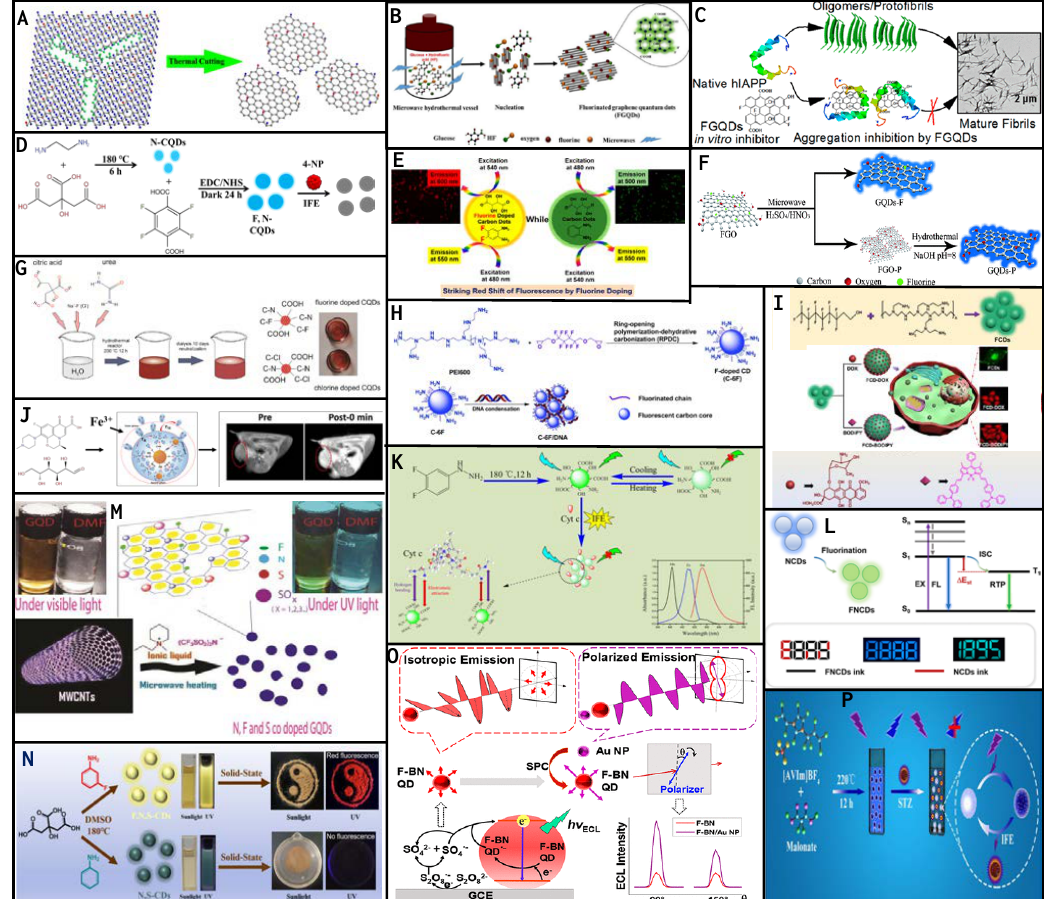
Figure 5. Synthesis and applications of F-doped CDs [59,61]. ( A ) F-GQDs were prepared using pyrolytic fluorinated graphite at 810 K. ( B ) HF was used as the dopant, and F-GQDs were synthesized by the microwave assisted hydrothermal method and ( C ) used to inhibit hIAPP polymerization. ( D ) Schematic diagram of FN-CQDs synthesis and used for 4-NP detection. ( E ) Prominent red shift in the fluorescence by F-doping used for cell imaging. ( F ) FGO synthesizes F-GQDs as the precursor. ( G ) Synesthetic route of the F-CQDs. ( H ) F-CDs were prepared using the RPDC method and polymerized with a DNA molecular chain. ( I ) Schematic of F-CDs, F-CDs-DOX, and F-CDs- BODIPY fabrication and the cellular uptake of F-CDs-DOX. ( J ) FN-CQDs were synthesized with levofloxacin and glucose by microwave assisted synthesis, and combined with Fe 3+ as the contrast agent. ( K ) Illustration of F, N-CDs synthesis, and the detection principle for Cyt c and temperature. ( L ) Formation of RTP is related to the cross-stable triple excited states in the system, and FN-CDs are used as the anti-counterfeiting fluorescent ink. ( M ) High QY (70%) NFS co-doped GQDs were synthesized using the microwave method with a customized ionic liquid base. ( N ) NFS co-doped CDs were synthesized by the solvothermal reaction of citric acid and m-fluoroaniline in the presence of DMSO. ( O ) Polarized SPC-ECL mechanism of the F-BN QDs. ( P ) N, B, and F co-doped CDs